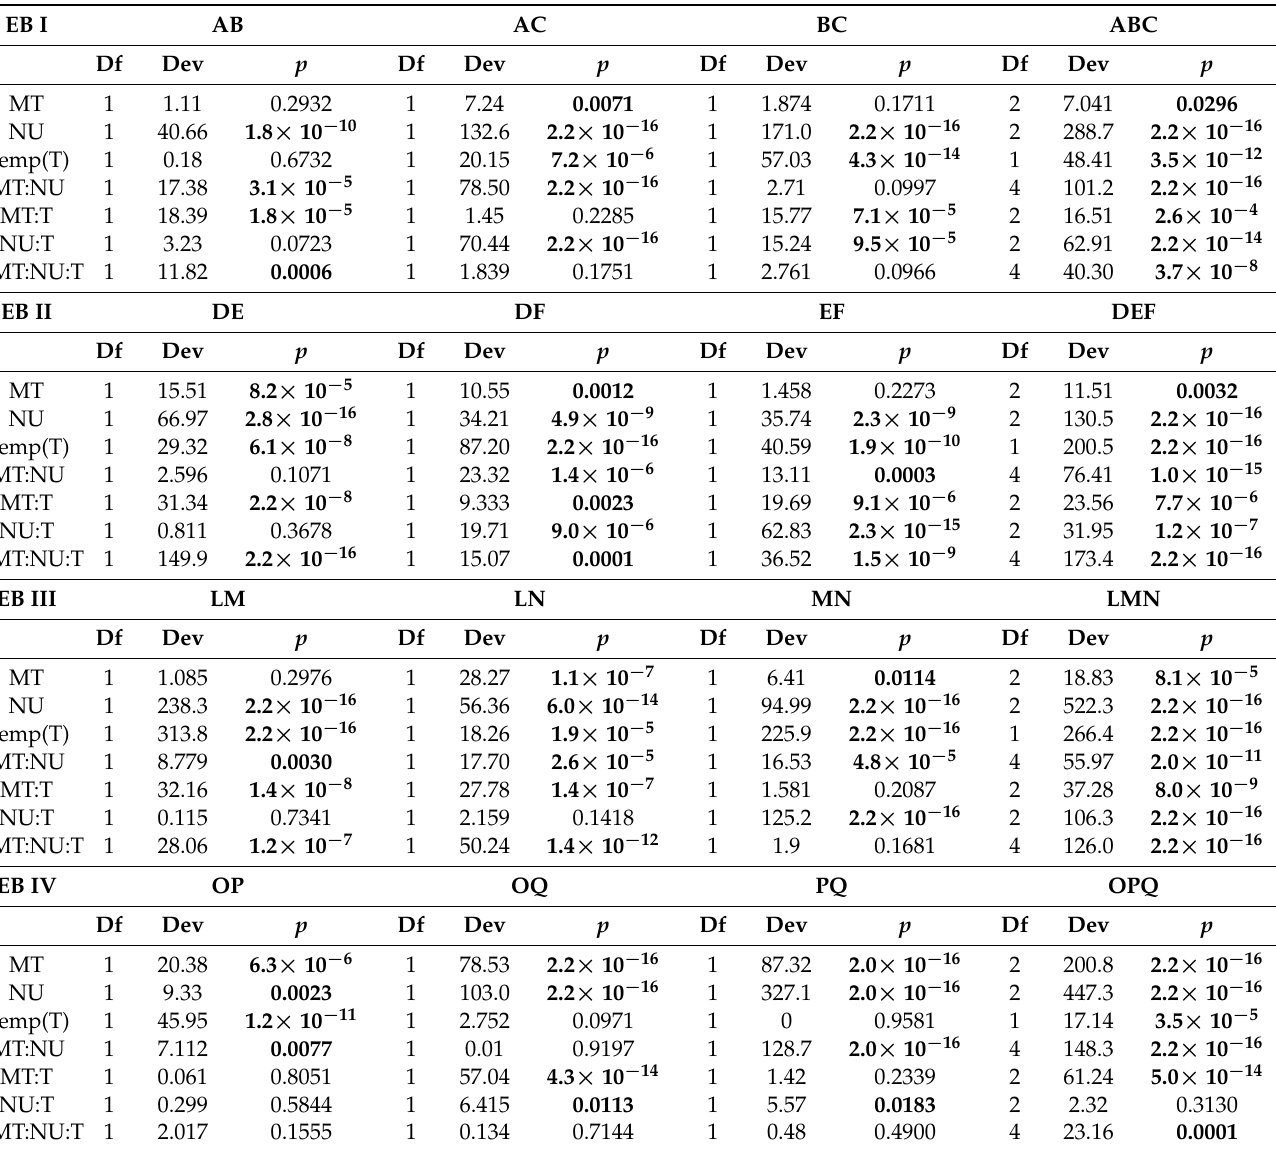
Table 10. The effect of mitochondrial haplotype (MT), nuclear genetic background (NU), temperature (T) and their interactions on Egg-to-adult viability for three pairwise comparisons and the experimen- tal block (EB) analysed as a whole for each of the four experimental blocks. DF, degrees of freedom; Dev, deviance; p values that are significant at p < 0.05 are given in